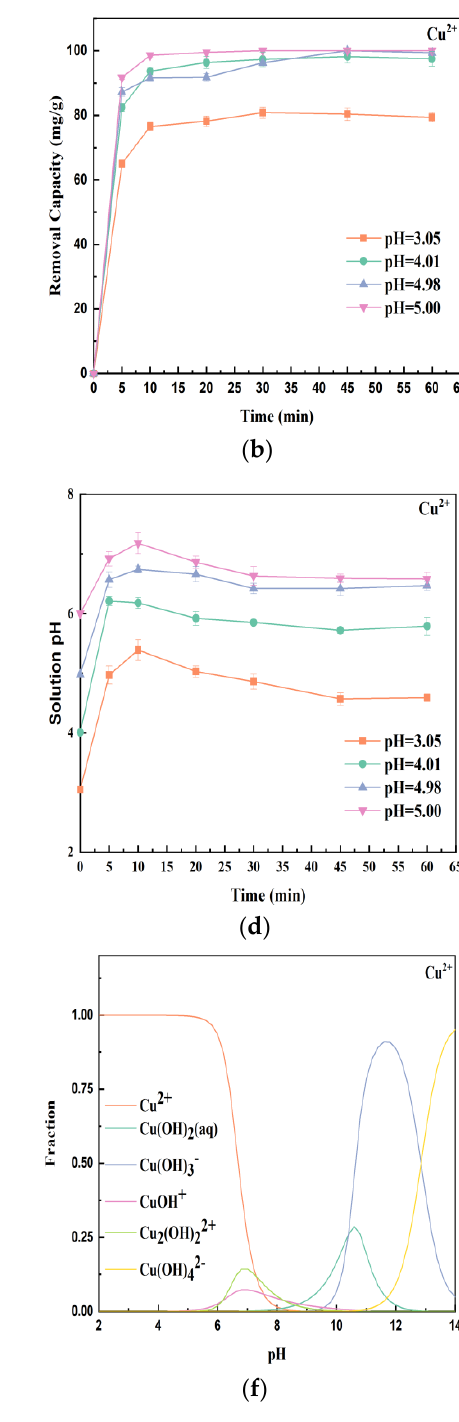
Figure 4. Effect of the initial solution pH on the ( a ) Cd 2+ and ( c ) Cu 2+ removal by SB-NZVI(1:4-900) composites; the change in solution pH during the reaction of ( b ) Cd 2+ and ( d ) Cu 2+ removal; the ( e ) Cd 2+ and ( f ) Cu 2+ species distribution as a function of pH.